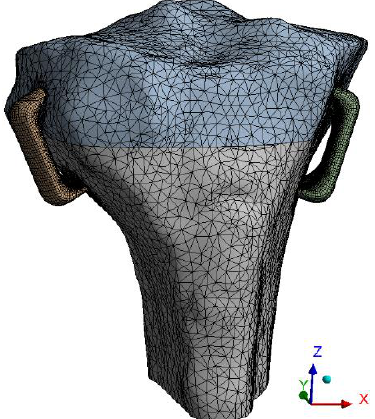
Figure 8. FEM model of the bone and staples. Staples were discretized by a hex-dominant mesh (SOLID186 + some SOLID187 ele- ments) with a global maximum element size of 0.5 mm. The element size was locally re- fined on radii and in the immediate vicinity of these areas; see Figure 9.